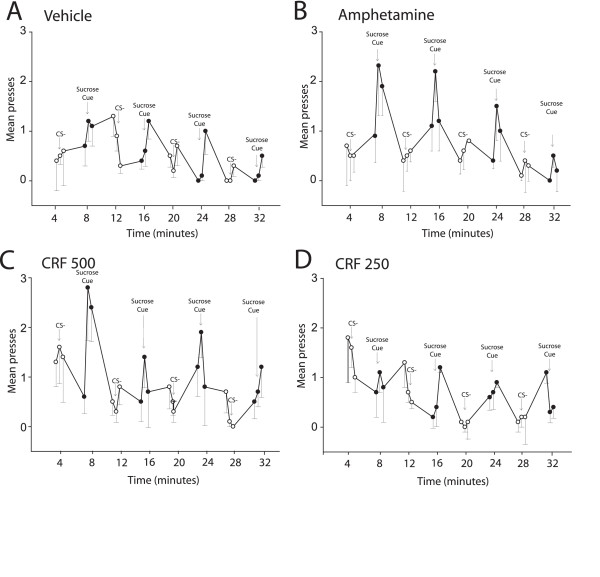
Temporal pattern of lever pressing within test session. Minute-by-minute time-course of lever pressing peaks on sucrose-associated lever after microinjections of (A) vehicle, (B) amphetamine 20 μg, (C) CRF 500 ng, and (D) CRF 250 ng. Open circles depict lever pressing during presentation of the 30-sec CS- and filled circles during presentation of the CS+. Lever pressing is also shown during the 30 sec period before each CS+ or CS- (precue baseline), and during the 30 sec period that followed each CS+ or CS- (post-cue period). Both CRF (500 ng) and amphetamine (20 μg) magnified intense, transient, reversible, and repeatable peaks in pressing on sucrose-associated lever each time the CS+ occurred. Magnified lever pressing after CRF (500 ng) or amphetamine (20 μg) was triggered by each presentation of the sucrose cue, but then was followed by a rapid descent back to normal baseline levels of pressing once the cue ended (B and C).